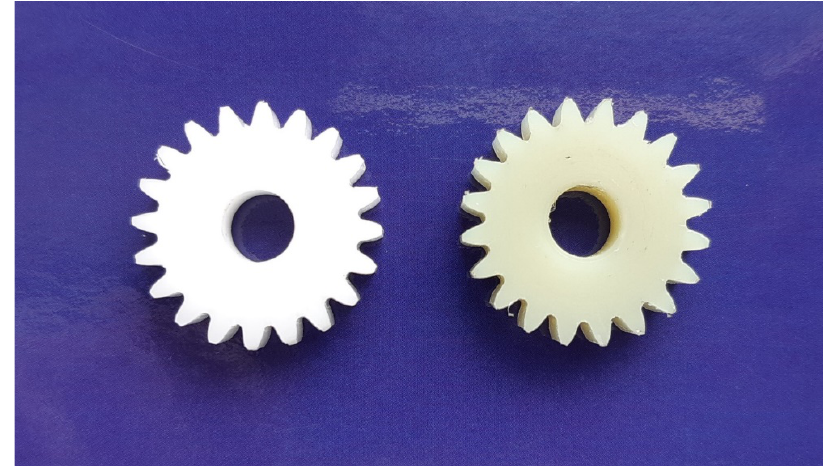
Figure 3. The driver gear (POM) and the driven gear (PA66) of a gear pair. To minimise the noise emitted by the electric motor, bearings and toothed belt with pulley, the test gears were protected with soundproof acoustic foam. The tested gears were operated like in a semi-anechoic chamber, which is shown in Figure 4.